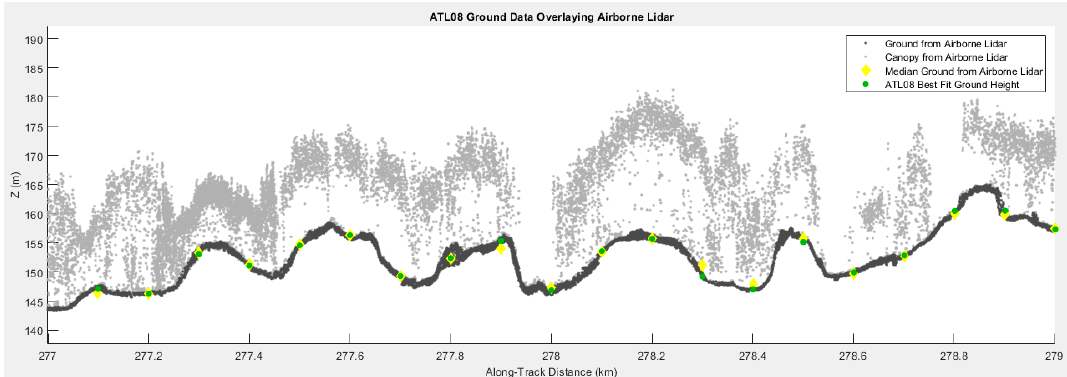
Figure 9. A subset of the ATL08 terrain height validation results from track ATL08_20181124001516_08610105 over Finland. The airborne lidar point cloud (truth) are shown as grey dots where the canopy and terrain points have been isolated [14,27]. The median terrain height derived from the airborne lidar data are shown in yellow, and the ATL08 Best Fit terrain height is shown as green.